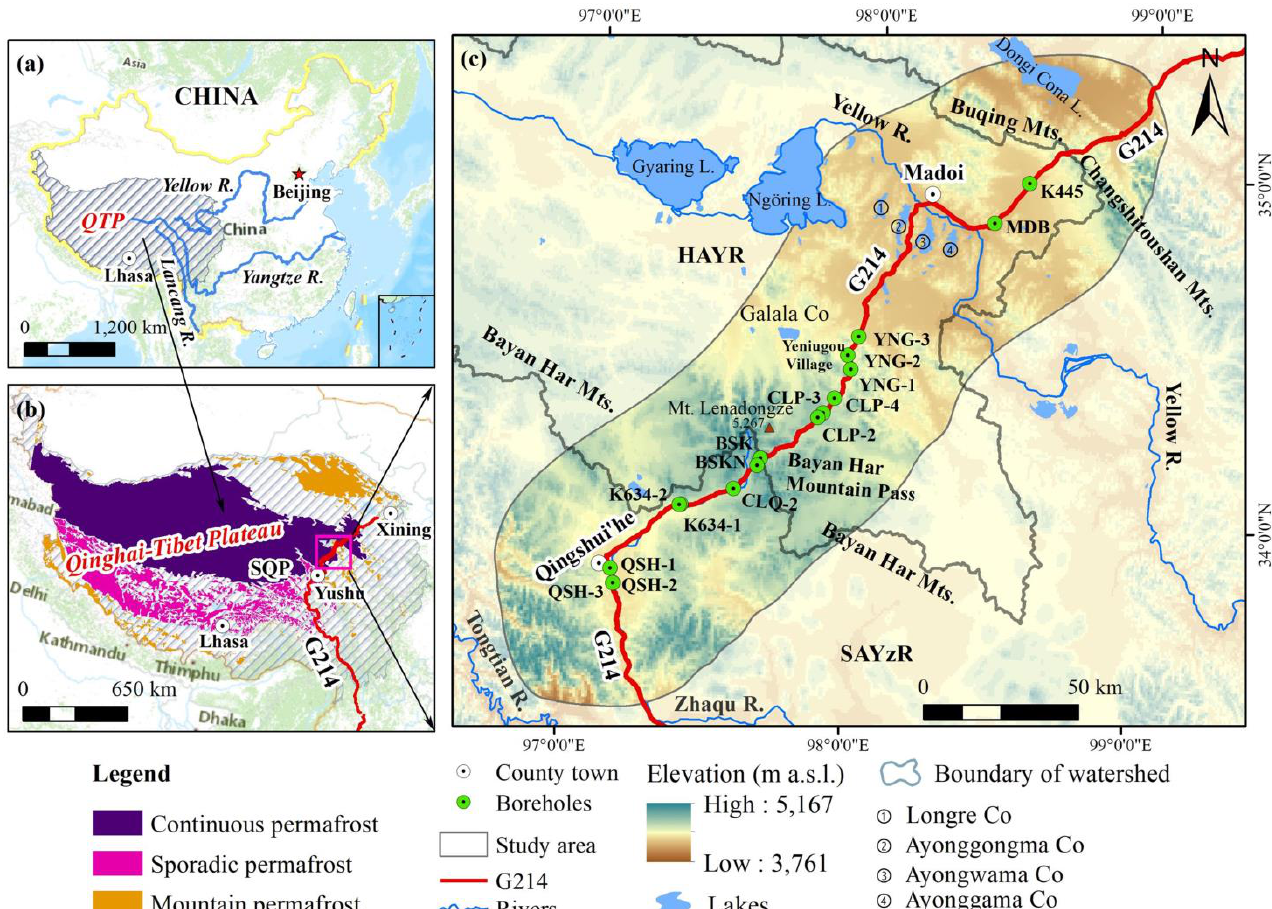
Figure 1. Location map of the study area on northeastern Qinghai – Tibet Plateau in West China. Notes: ( a ) Relative location of the Qinghai – Tibet Plateau in China; ( b ) National Highway 214 (G214) (red line) across the southern Qinghai Plateau (SQP) and the key study segment of G214 across the Bayan Har Mountains (pink box). Permafrost distribution on the upper panel is derived from a global permafrost zonation index [66]; ( c ) Permafrost boreholes (green points), county towns (white points), rivers and lakes (blue line and areas), and study area (highlighted black-bordered box, a 60 km wide buffer zone mapped along each side of the G214).